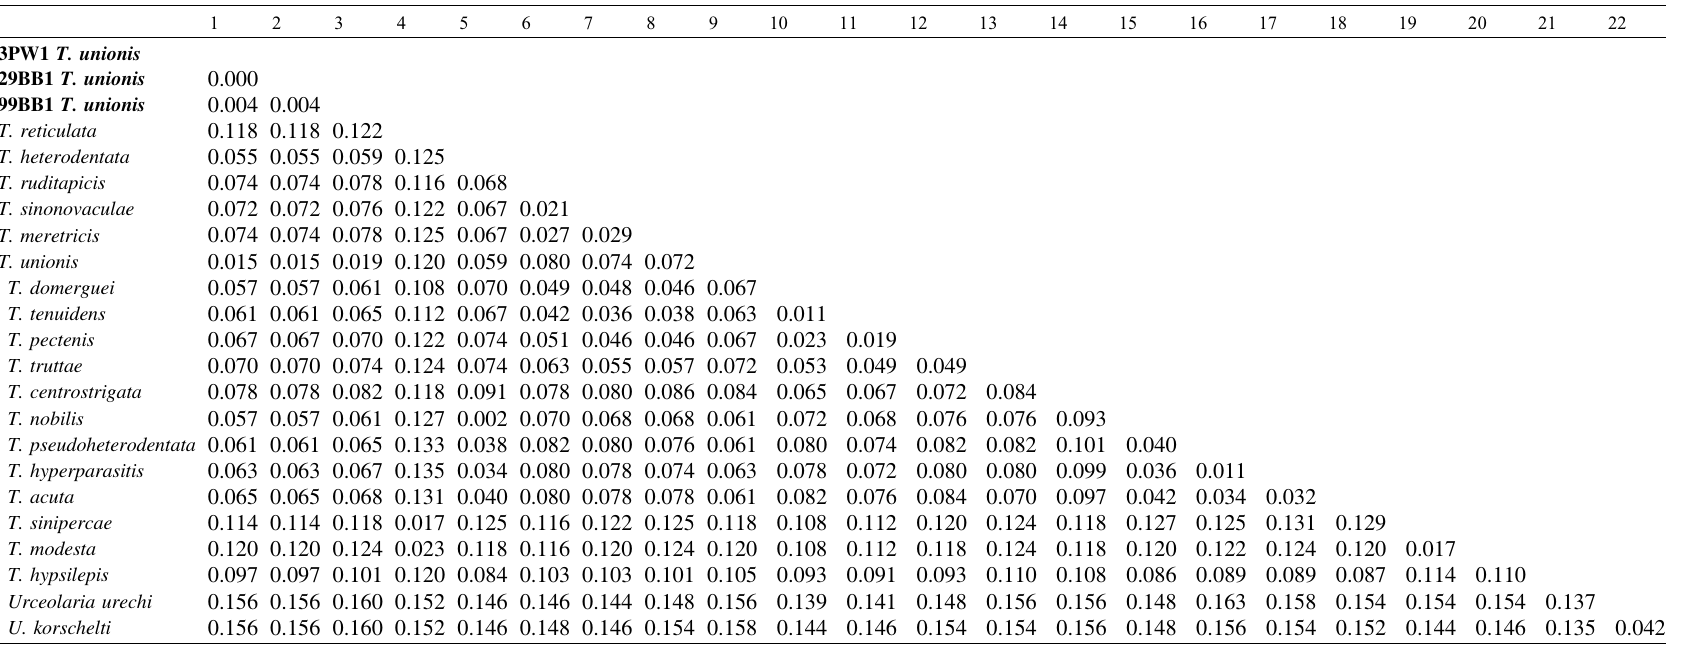
Table 4. Pairwise analysis of distance estimation among sequence data of the trichodinids derived from the 18S rRNA region using the p-distance method. The bold taxa referred to the present